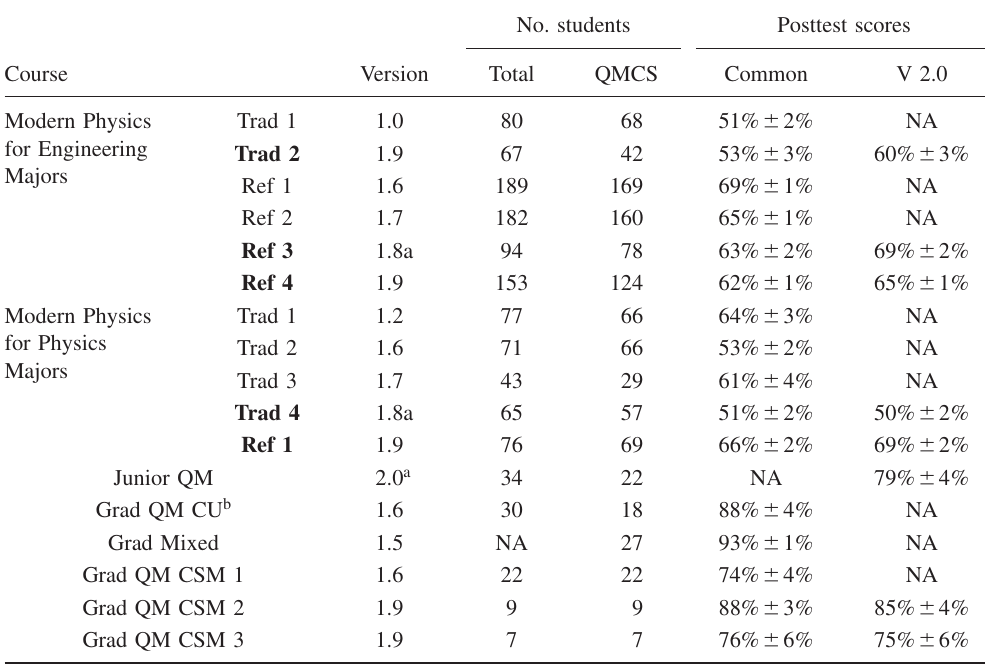
TABLE III. Average posttest scores in different courses for common questions asked all semesters and for Version 2.0 questions. V is the version number given in each course. We list the total number of students enrolled at the beginning of the semester, along with the number of students who took the QMCS posttest in each course. Uncertainties are standard errors on the mean. Courses in bold were given a version that included all questions in Version 2.0 and are thus included in the analysis of Version 2.0 in Secs. IV C 3